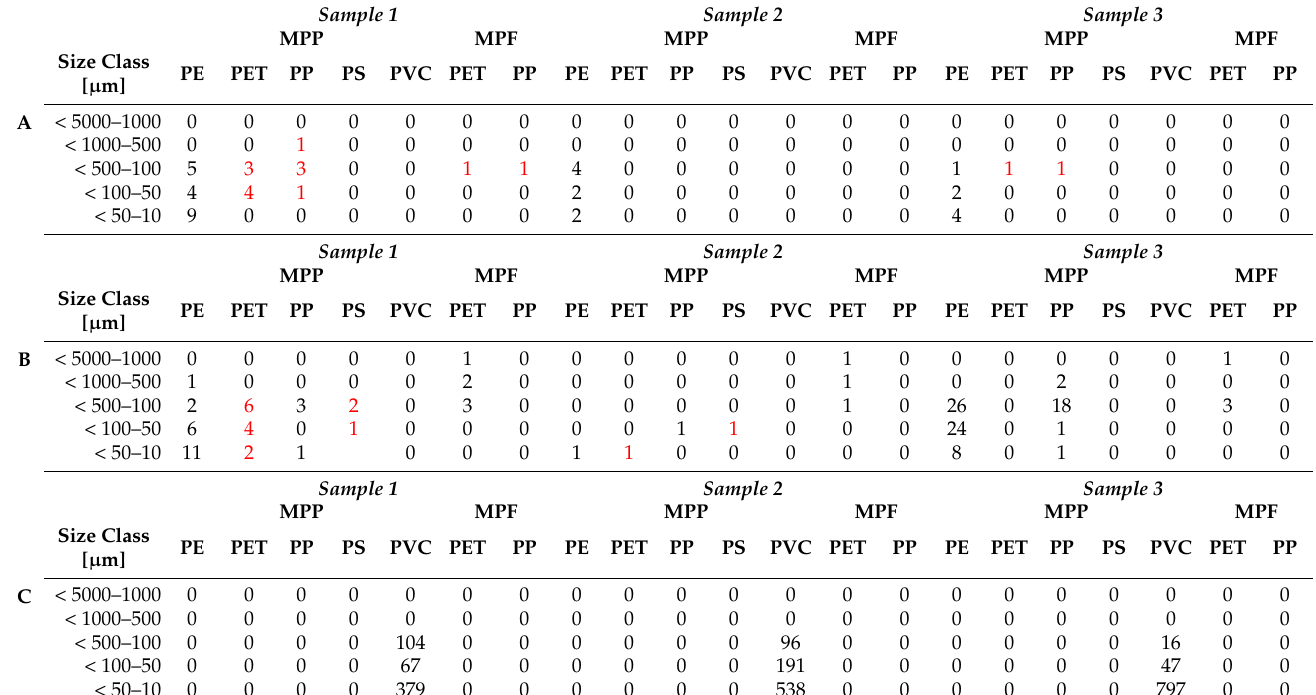
Table A3. Non-extrapolated numbers of MPP and MPF identified in the sand filter effluent of each sample of the